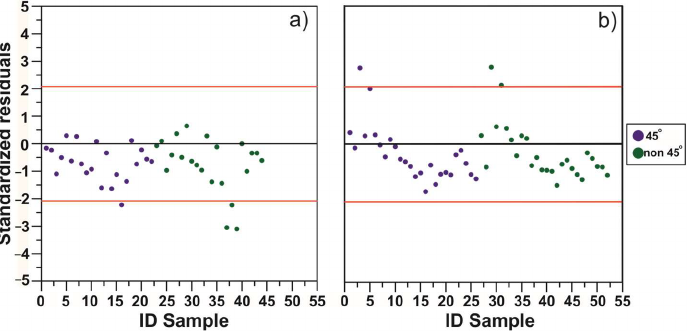
Figure 5. Analysis of standardized residuals. ( a ) 𝑍 (cid:3020)(cid:3005) model; ( b ) 𝐶 ℎ 𝑙 𝑎 model. Table 10. Least-squares analysis for the and 𝑍 (cid:3020)(cid:3005) and 𝐶 ℎ 𝑙 𝑎